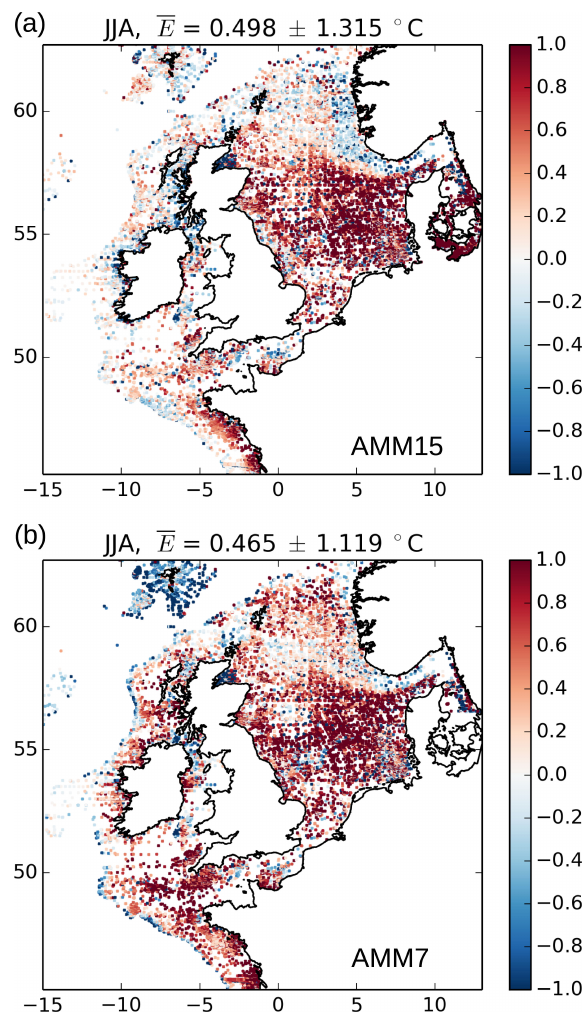
Figure 7. Mean seasonal bottom temperature anomalies for model minus observations ( ◦ C). Both panels show 20-year mean seasonal anomalies for summer (JJA), 1991–2010. Observations used are monthly EN4 profiles (Good et al., 2013). Panel (a) shows anoma- lies for AMM15-EN4, panel (b) shows anomalies for AMM7-EN4. Mean errors ( E ) are calculated for the AMM15 domain region, where bathymetry <